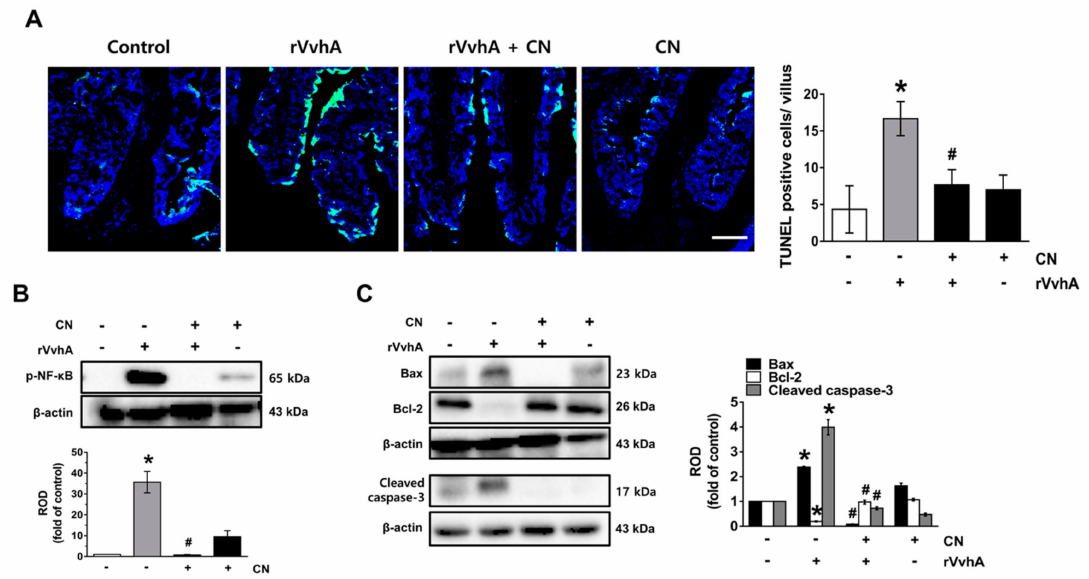
Figure 6. CN functionally blocks apoptotic responses caused by rVvhA in the mouse. The functional role of CN in apoptotic responses caused by rVvhA in the mouse ileum were evaluated in ileal-ligated mouse model after treatments with CN (10 − 2 mg / kg) and rVvhA. ( A ) The apoptotic cells (green) in frozen sections were detected by TUNEL assay using an apoptosis detection kit. Quantification of TUNEL-positive cells (right) are shown. n = 6. * p ≤ 0.001 vs. control. # p ≤ 0.001 vs. rVvhA alone. The level of NF- κ B ( B ), Bax / Bcl-2 and cleaved caspase-3 ( C ) are shown. Data represent the mean ± S.E. n = 6. * p ≤ 0.001 vs. control. # p ≤ 0.001 vs. rVvhA alone. ( B – C ) ROD is the abbreviation for relative optical